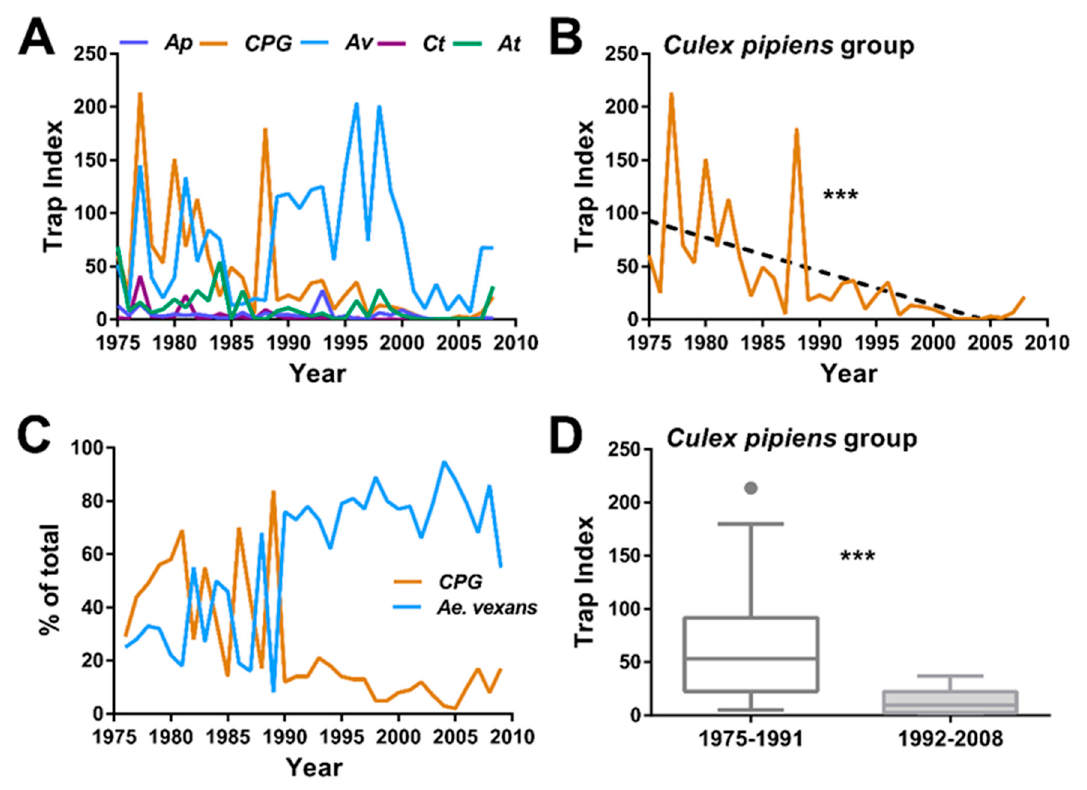
Figure 2. Temporal analysis of mosquito abundance from the Ames, Iowa trap site (1975–2008). Trap index averages (standardized abundance) for each year at the Ames site for the five most abundant mosquito species ( A ): Anopheles punctipennis ( Ap ), Culex pipiens group (CPG), Aedes vexans ( Av ), Culex tarsalis ( Ct ), and Aedes triseriatus ( At ). A significant decline in CPG populations were detected over the study period when analyzed by simple linear regression (R 2 = 0.3719, p < 0.0001, F = 18.95, df: 1, 32) ( B ) The dynamics between the two most abundant species, Ae. vexans and CPG, are more apparent when examined by relative abundance where distinct differences in populations are observed sometime after 1990 ( C ). When CPG populations are compared between the first half of the trapping period (1975–1991) and the second half (1991–2008), there are significant differences in the overall trap index when analyzed using Mann-Whitney analysis ( p < 0.0001, two-tailed, exact) ( D ).